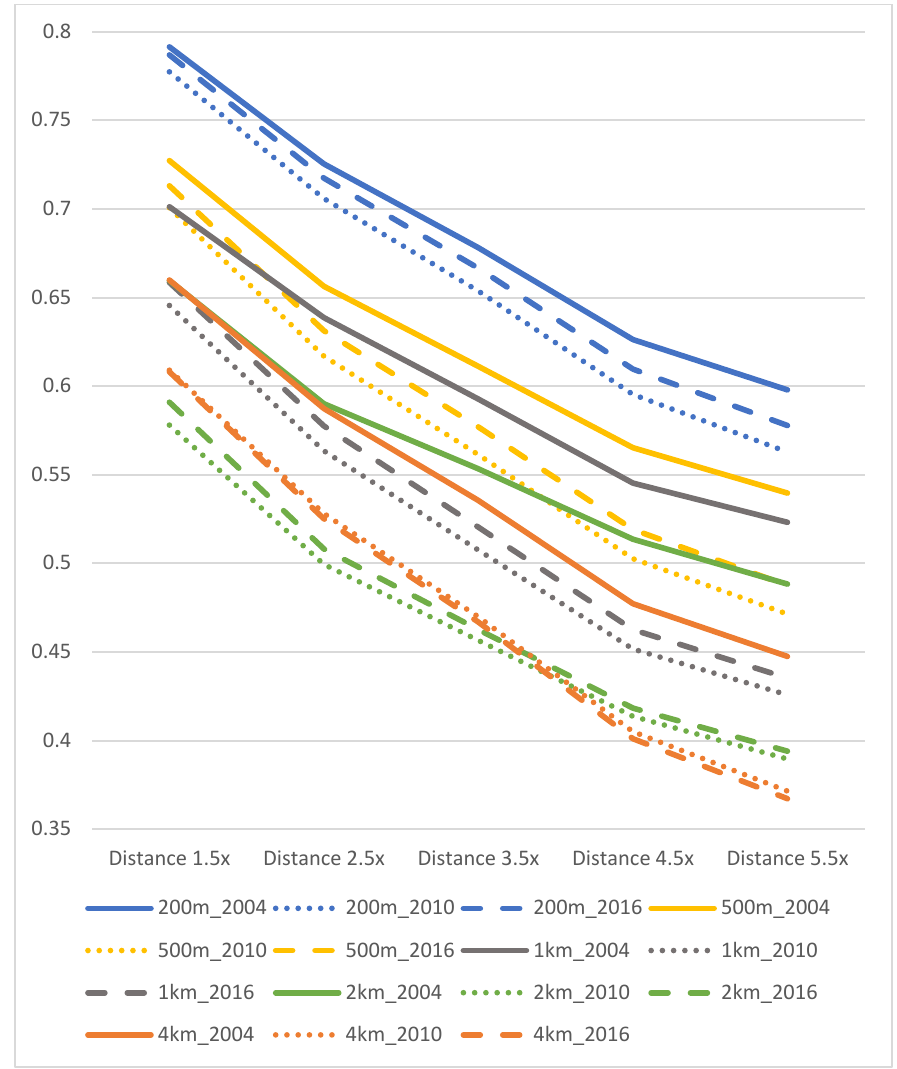
Figure 5. The global spatial autocorrelation change in ESD by scale and level distance. Moran’s I analysis computing was performed in 1 ArcGIS Engine node in the Computing Center.